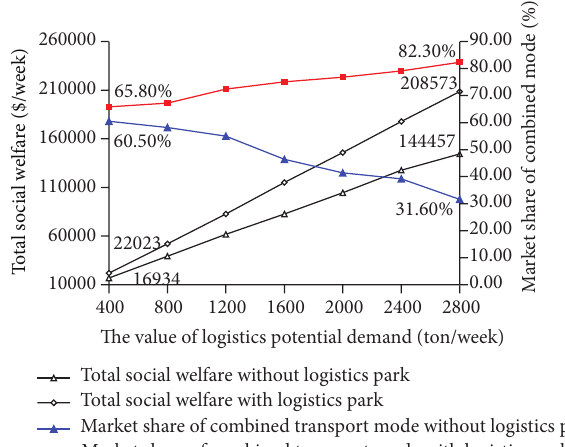
Figure 9: Social welfare and market share of combined mode com- parison with constructing logistics parks and without constructing logistics parks.